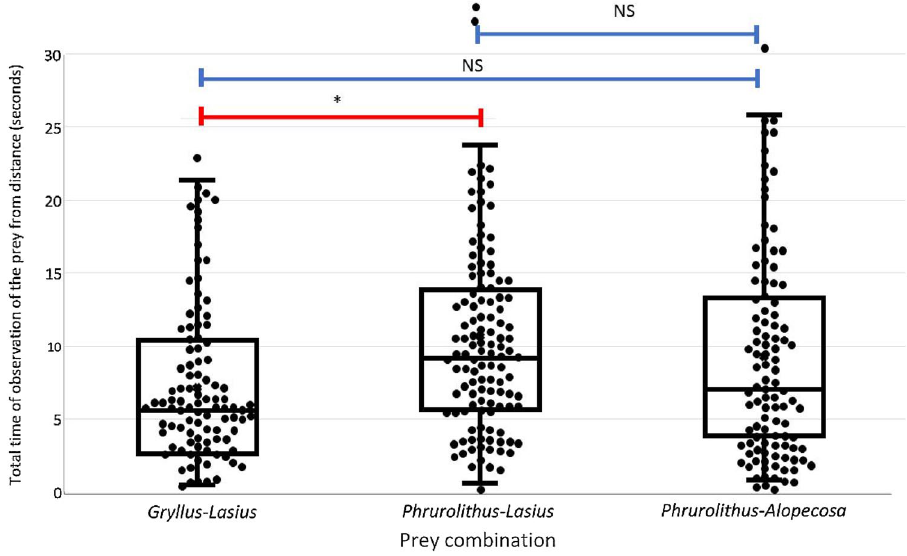
Figure 2. The total time spent observing the pair of prey offered simultaneously. Gryllus —Mediterranean cricket ( Gryllus bimaculatus ), Lasius —black garden ant ( Lasius niger ), Phrurolithus —myrmecomorph spider ( Phrurolithus festivus ), Alopecosa —non-myrmecomorph wolf spider of genus Alopecosa . Median marked with horizontal line, box refers to 25–75% quartiles, whiskers 10–90% quantiles. All data represented by dots. Red lines with an asterisk above the columns indicate significant difference, blue lines indicate non-significant difference (NS) 42